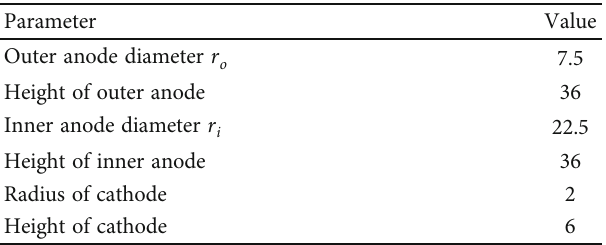
Table 5: The normalized geometric parameters.